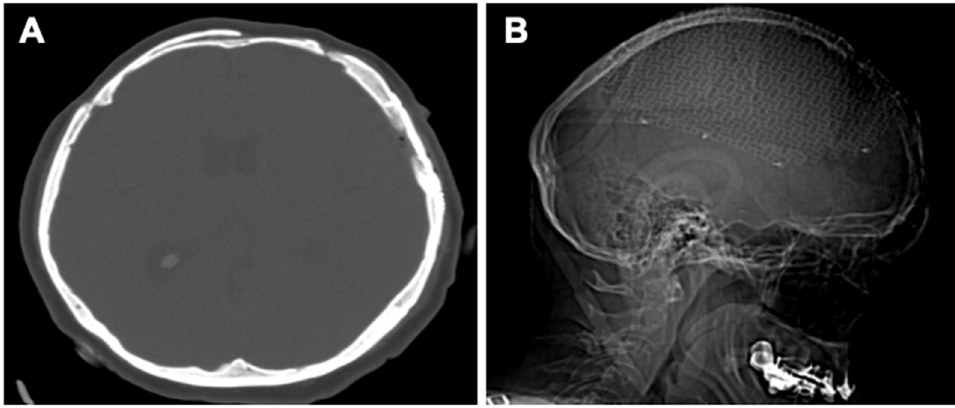
Figure 3. Postoperative neuroimaging: ( A ) Axial CT scan. ( B ) Sagittal radiographic scan.